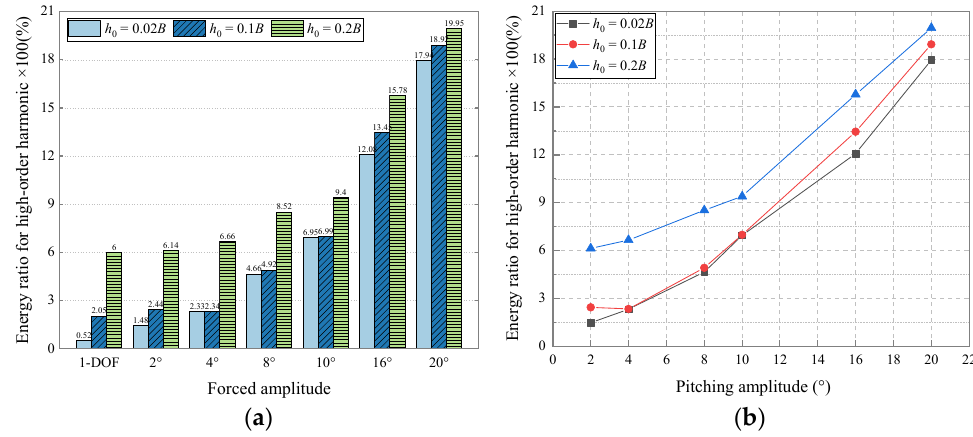
Figure 21. Proportion variation in high-order harmonic components of aerodynamic moment with different pitching amplitudes. ( a ) Comparison of the 1-DOF heaving motion with the 2-DOF coupled motion; ( b ) 2-DOF coupled motion.